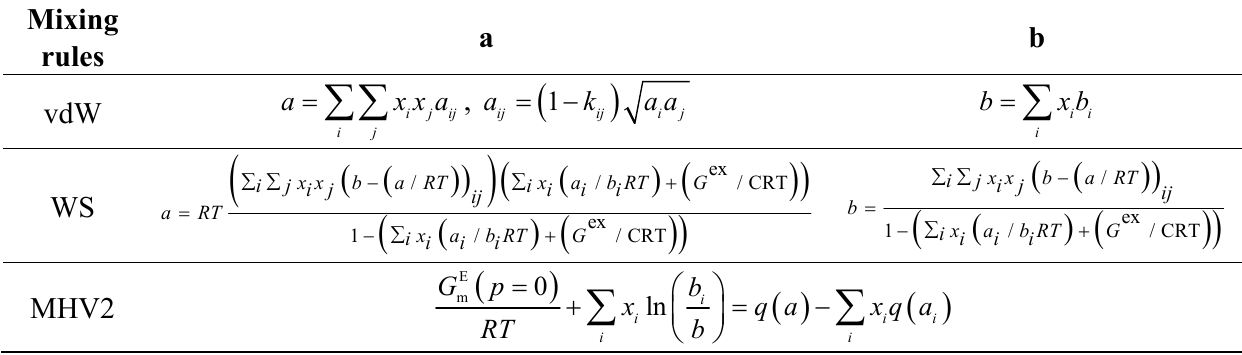
Table 2. Summary of studied mixing rules. vdW: van der Waals; WS: Wong-Sandler; and MHV2: modified Huron-Vidal second-order